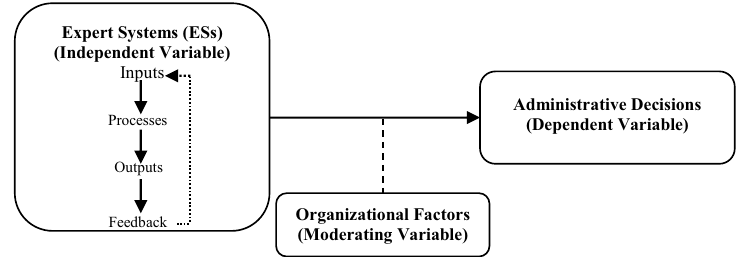
Figure 1. Research